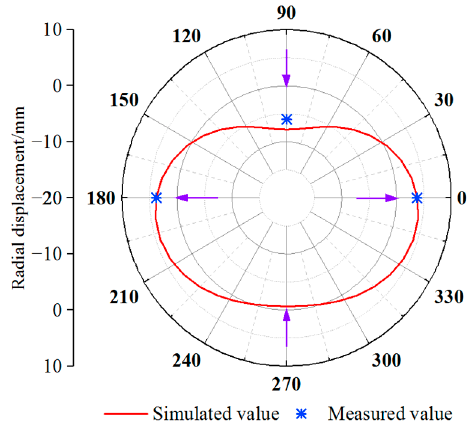
Figure 30. Lining ovality at TY-56. Table 4. Comparison of the measured values and the simulated values at monitoring sections.